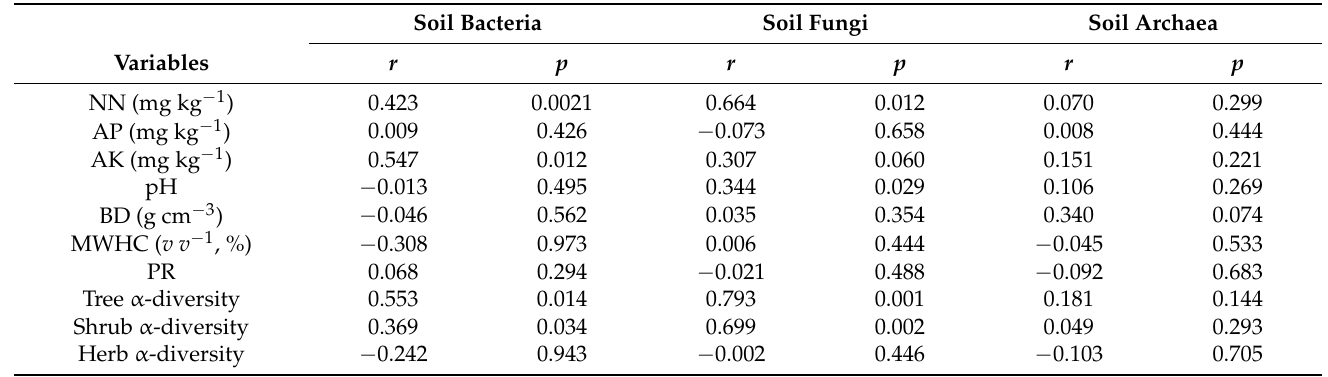
Table 9. The relationships between the environmental variables and the soil microbial community function based on man- tel test.